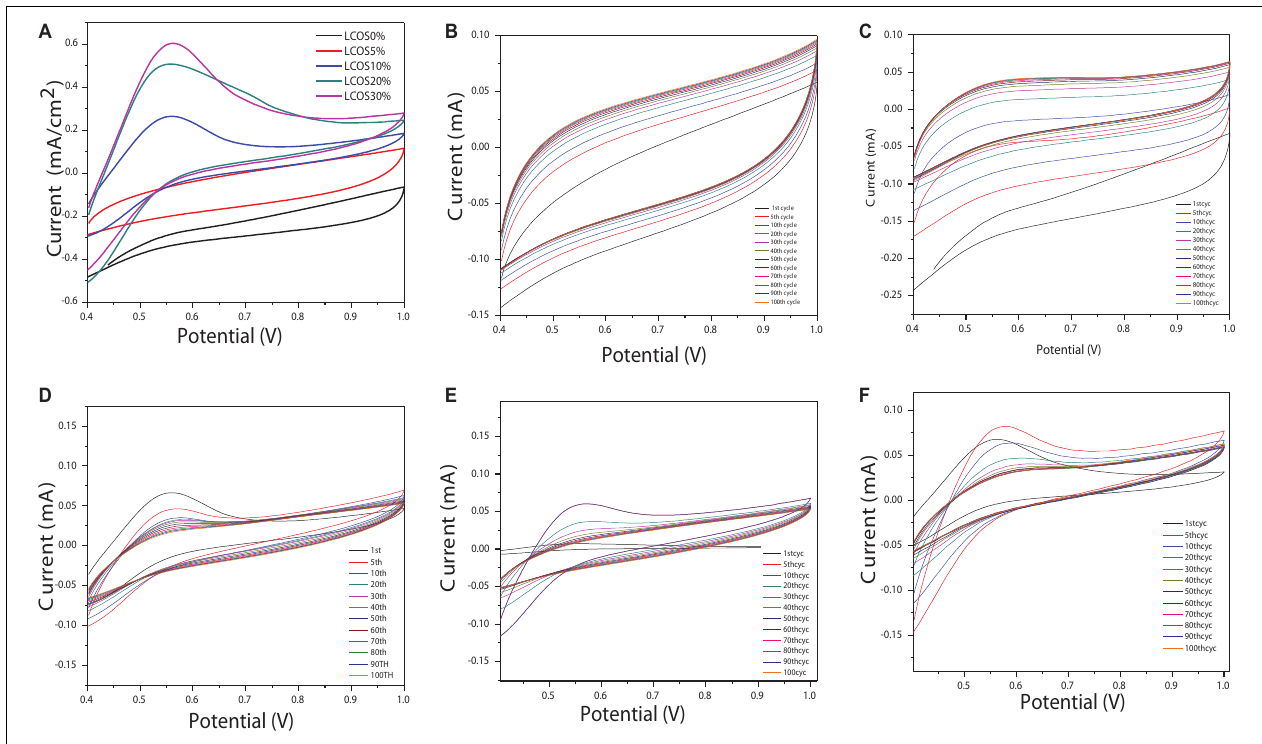
FIGURE 3 | (A) CV plots versus RHE of the LSCO-coated electrodes in 0.5 M H 2 SO 4 electrolyte recorded at 50 mV/s and 25 ◦ C and normalized to the geometric area of the electrode. Overlay CV plots of the 1st, 5th, 10th, 20th, 30th, 40th, 50th, 60th, 70th, 80th, 90th, and 100th cycles of the (B) LSCO0%, (C) LSCO5%, (D) LSCO10%, (E) LSCO20%, and (F) LSCO30% at 0.5 M H 2 SO 4 electrolyte during repetitive potential cycles at 20 mV/s and 25 ◦